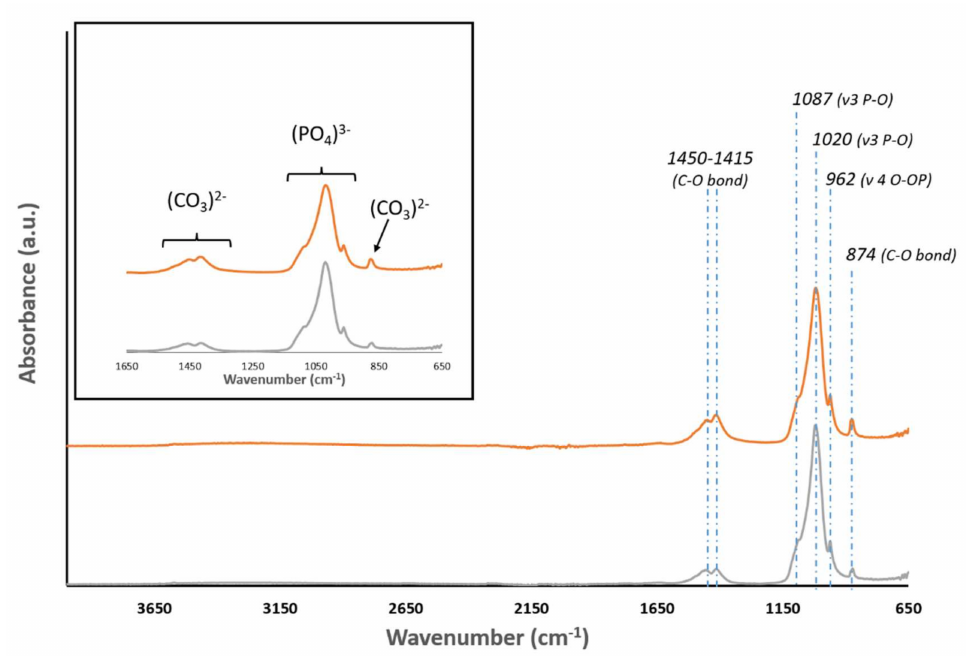
Figure 5. FTIR spectra of ABB (orange) and AEB (gray). Samples of both biomaterials exhibit main peaks around 1450–1415, 1020, 962, and 874 cm − 1